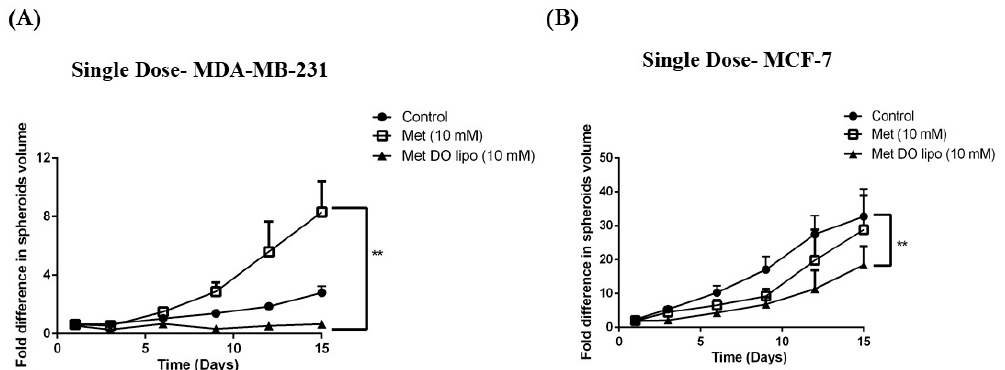
Figure 10. Effect of single-dose treatment on tumorigenic activity of breast cancer cells grown as 3D spheroids simulating conditions of in vivo xenograft tumor growth. ( A ) Quantified analysis of single-dose treatment on MDA-MB-231 spheroids. ( B ) Quantitative representation of anti-tumor activity of treatment expressed as fold difference in spheroid volume versus time. In MDA-MB-231 cells, treatment with Met DO lipo displays significant difference ( p < 0.01) in spheroid volume growth as compared to Met. Similarly, in MCF-7 cells, significant different ( p < 0.01 vs. control) can be observed on 15th day after treatment with Met DO lipo, whereas treatment with plain drug (Met) did not show any significant difference. Data represent mean ± SEM ( n = 6). Scale bar = 100 μ m. ** p < 0.01.